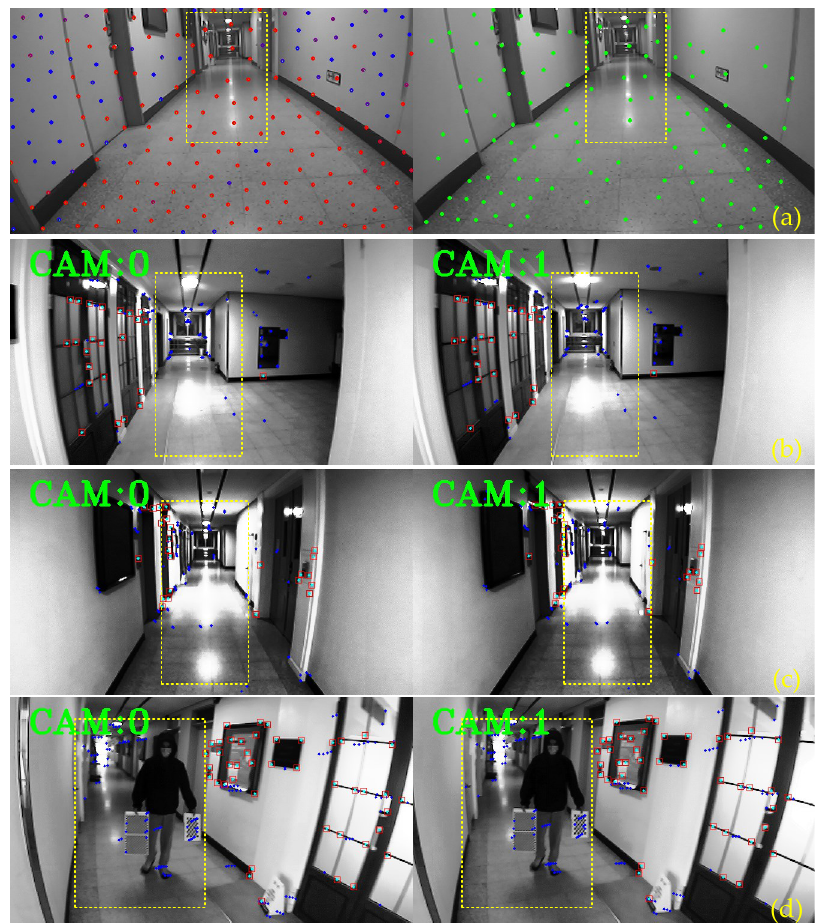
Figure 1. Experimental results in a dynamic environment influenced by illumination and a dynamic object. Herein, yellow rectangles present affected areas, small red squares indicate robust